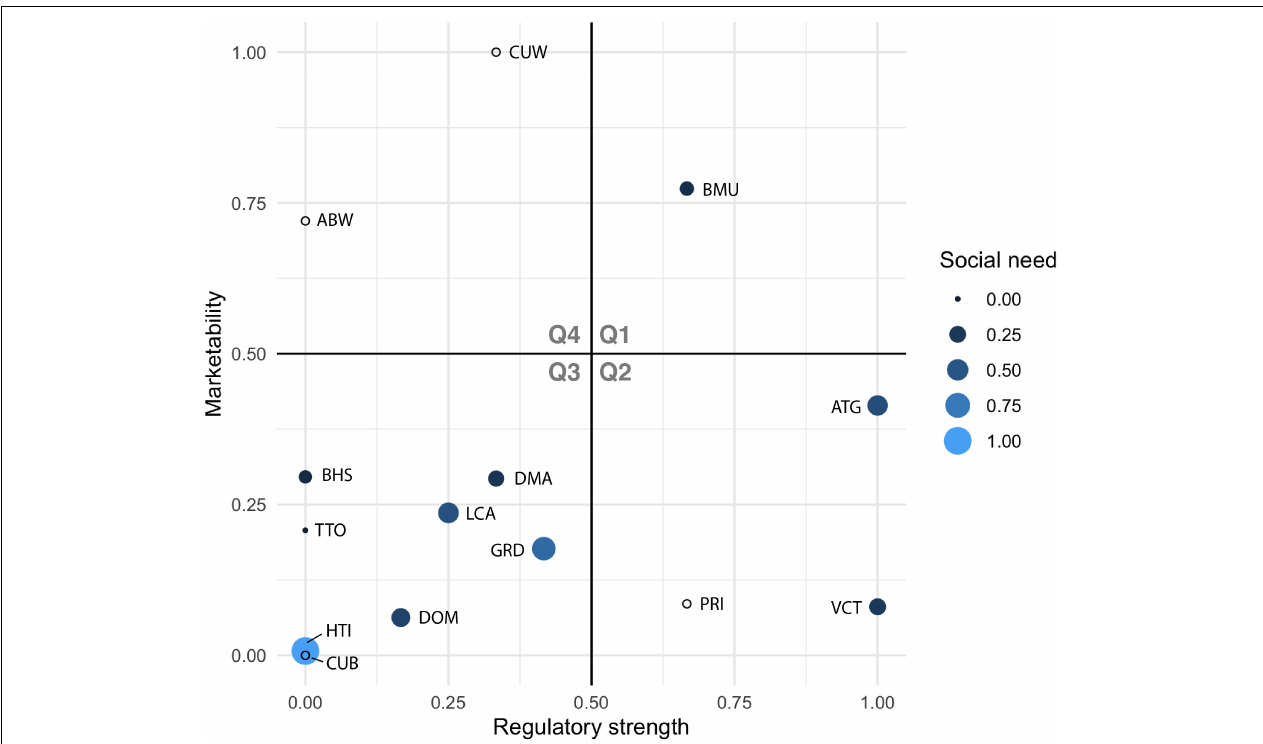
FIGURE 3 | Visualizing marketability, regulatory strength, and social need scores for insular Caribbean states and Bermuda to guide MFAD fishery approaches. Scores are scaled from 0 to 1 (see “Materials and Methods”), with states in Q1 having high regulatory strength and high catch marketability, states in Q2 having high regulatory strength but low catch marketability, states in Q3 having both low regulatory strength and catch marketability, and states in Q4 having low regulatory strength but high catch marketability. Circle size and color reflect social need scores, with open circles indicating social need data are not available. States without sufficient data to calculate marketability or regulatory strength scores are omitted here, but can be found in Table 1